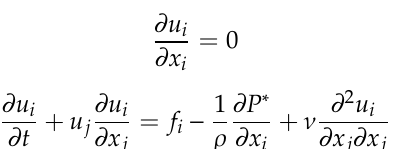
Figure 3. Enlarged view of the structured